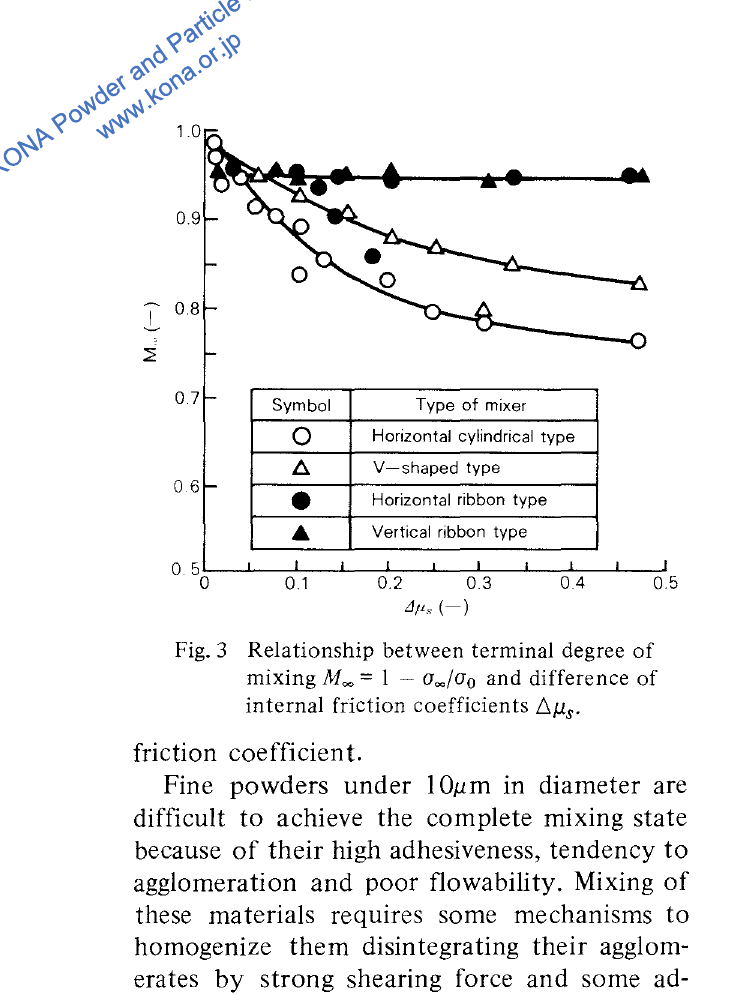
Fig. 3 Relationship between terminal degree of mixing M~ = I - a=fa 0 and difference of internal friction coefficients